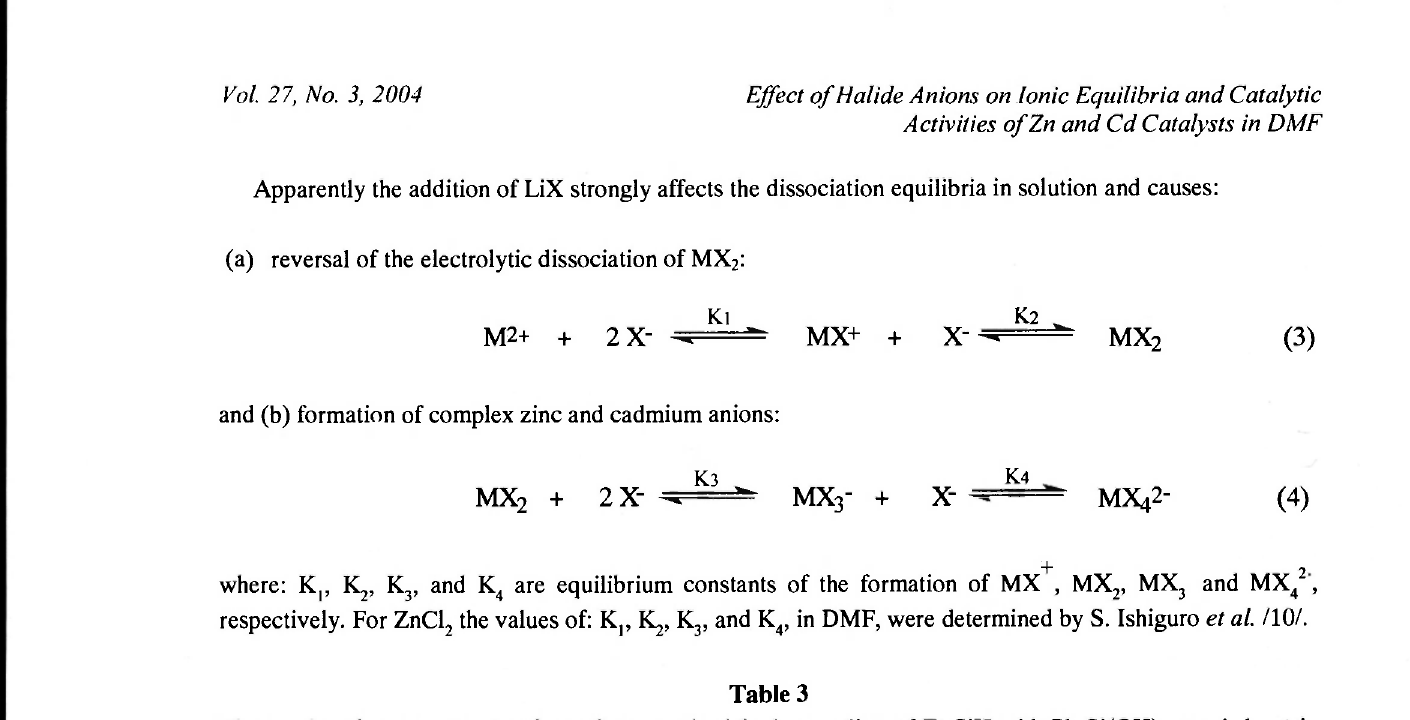
The results of measurements of reaction rates in dehydrocoupling of Et 3 SiH with Ph 2 Si(OH) 2 , carried out in the presence of Znl 2 and Lil (expts. 1-8) and Cdl 2 and Lil (expts. 9-14), in DMF at 25.0 °C.